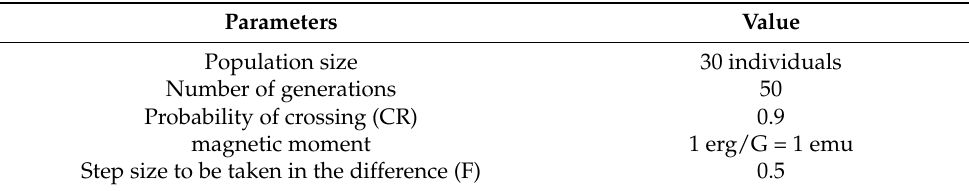
Table 3. DE algorithm parameter values.